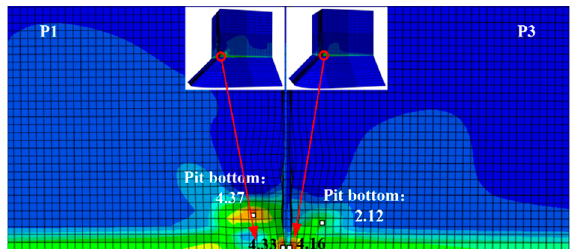
Figure 19. Distribution of equivalent plastic strain ε p at the corner of corroded piers of models P1